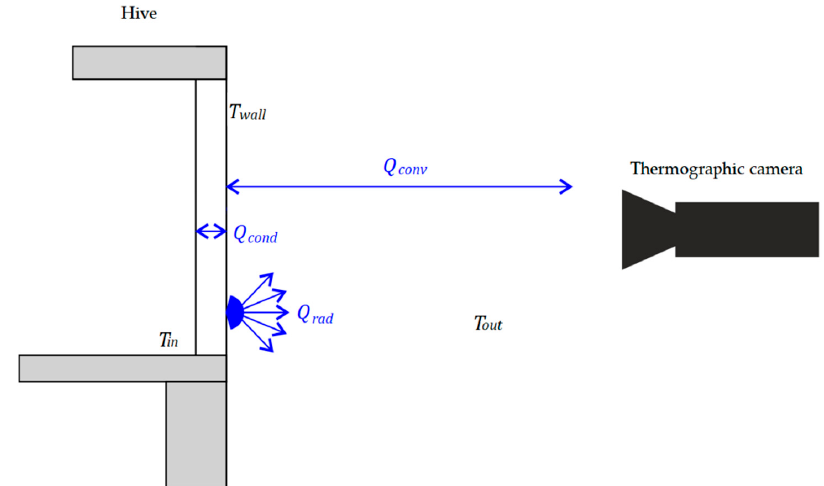
Figure 5. Diagram of the energy balance performed for the calculation of the inner temperature of the beehive: Heat flowing through the hive wall by conduction is equal to the heat exchanged from the outer surface of the hive wall to the outer air by convection plus the heat exchanged by this surface by radiation; both sources of radiation were received by the thermographic camera.